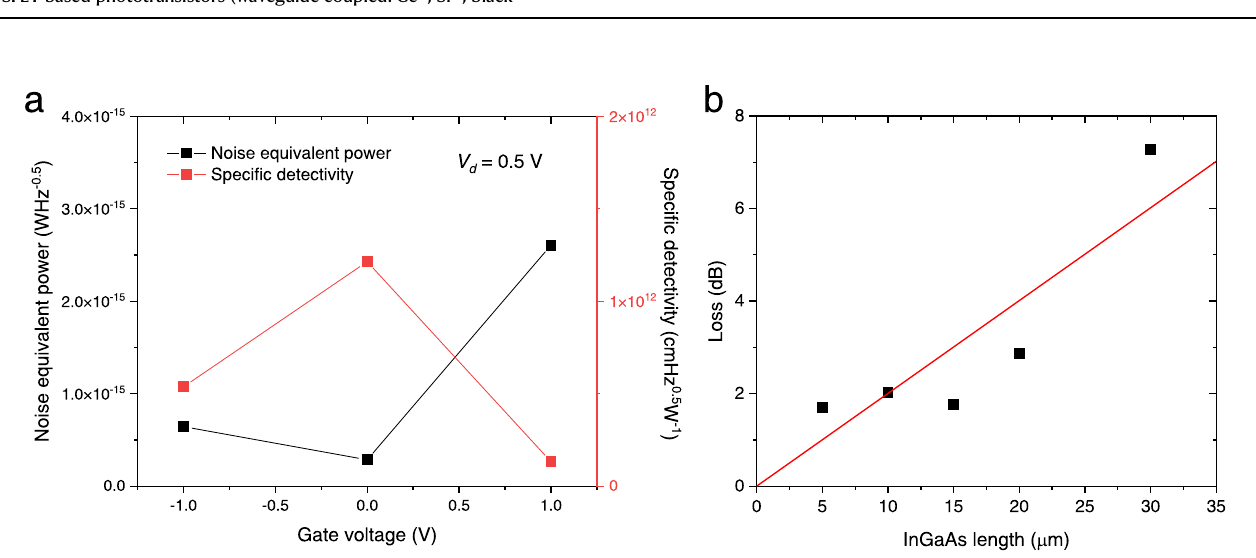
Fig. 5 | Benchmark of responsivity and response time for various photo- transistors based on metal-oxide-semiconductor fi eld-effect transistors (MOSFETs), bipolar junction transistors (BJTs), and junction fi eld-effect tran- sistors (JFETs). Comparison of responsivity and response time demonstrated for MOSFET-based phototransistors (waveguide-coupled: Ge 31 , Si 43 , black